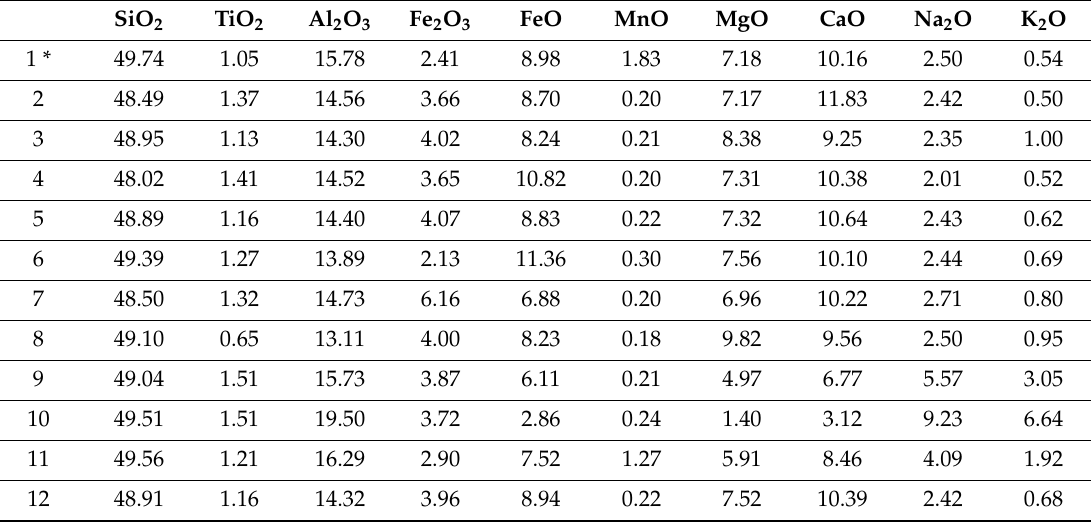
Table 2. The average composition (%) of the studied basic-ultrabasic rock groups in the Kola region and the granulite belts of